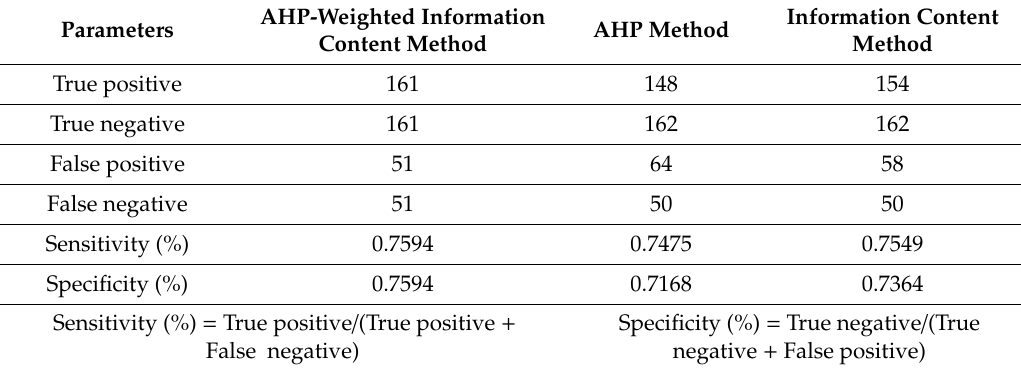
Table 5. Model performance of the three